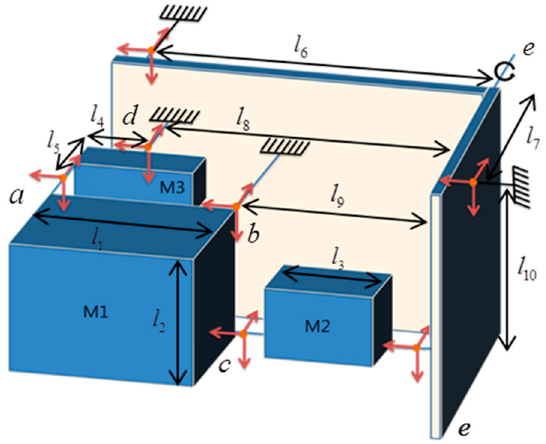
Figure 1. Demonstration of four components.